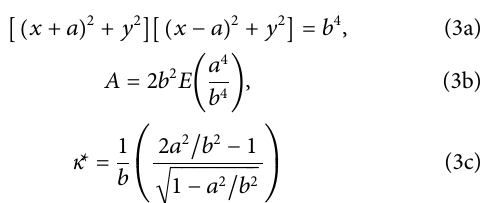
FIGURE4| Active constituentsaccumulate alongboundariesduetotheirpersistent self-motion,withasigni fi cantincrease indensity and polarorderalongcurved boundarieswithlargeconcavity. (A – C) :Densityandpolarization fi eldsaroundacircularobstacle(radiusoverrunlength R / ( U 0 τ R ) (cid:1) eyearoundthefaintincreaseincontours.The fi eldsarenormalizedby n ∞ ,thebulkconcentrationofactiveparticlesfarawayfromtheboundary. (D – F) :theconcentration and polarization fi elds around acurved obstacle with large concavity( R inner /( U 0 τ R )=1/2, R outer /( U 0 τ R )=1).Aconvex, circular obstacle experiencesa12 % increasein active particle accumulation, while a concave shape in the same active bath experiences a 40 % increase in active particle accumulation at the inner side, indicating that the speci fi c arrangement and shape of obstacles play a key role in the effective diffusivity of active particles. We used the same obstacle area fraction of σ ≈ 5 . 5 % and (cid:6)(cid:6)(cid:6)(cid:6)(cid:6) (cid:19) activity U 0 τ R / δ =1 in both cases, where δ (cid:1) D T τ R is the microscopic